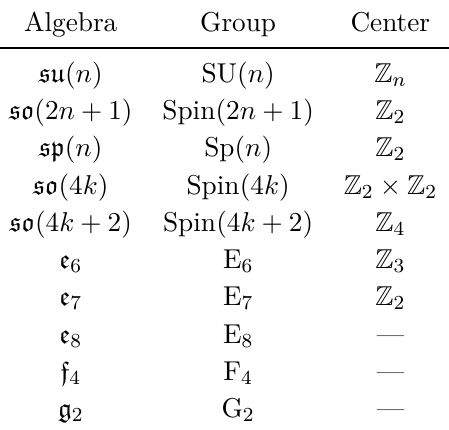
Table 5. Centers of various groups. If a center is not specified, the center of the group is trivial. n and k are